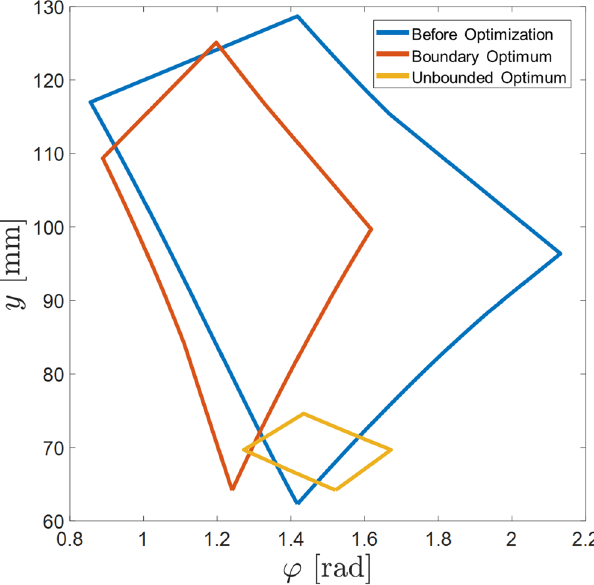
Figure 10. Workspaces of design variables before and after optimization. The area of the workspace is smallest with unbounded optimal design, therefore unsuitable for the